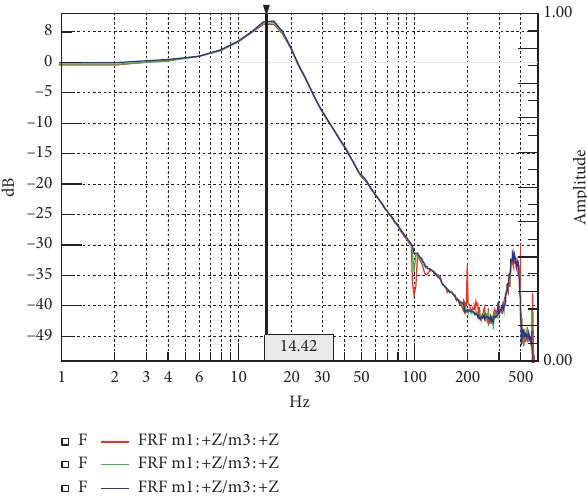
Figure 21: Acceleration transfer rate along Z -direction in different excitation